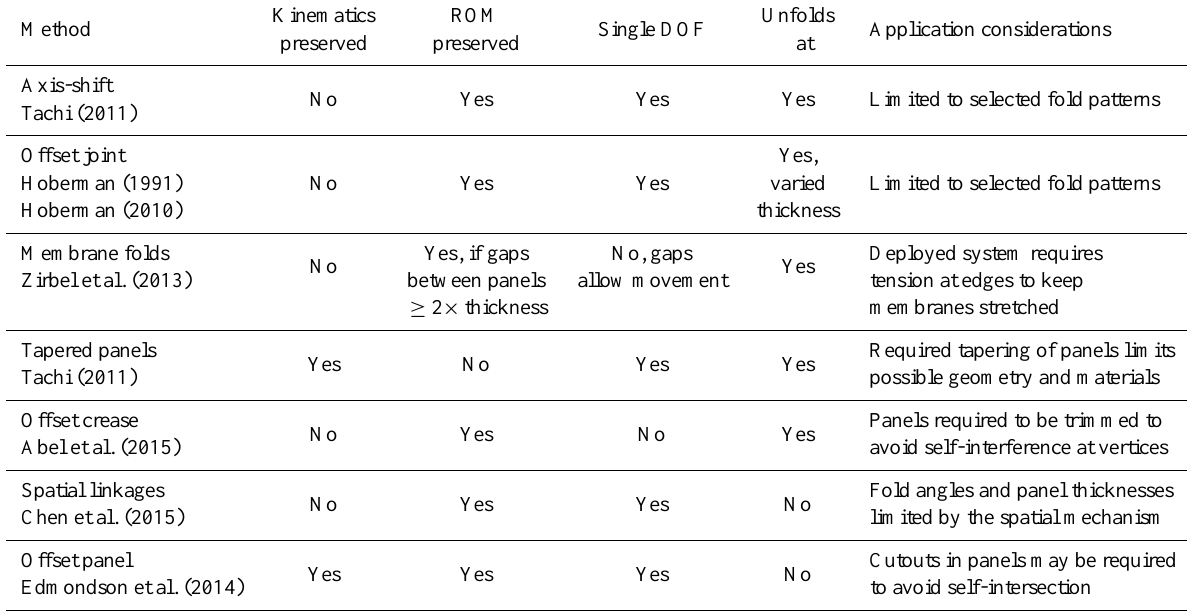
Table 1. A comparison of thickness accommodation